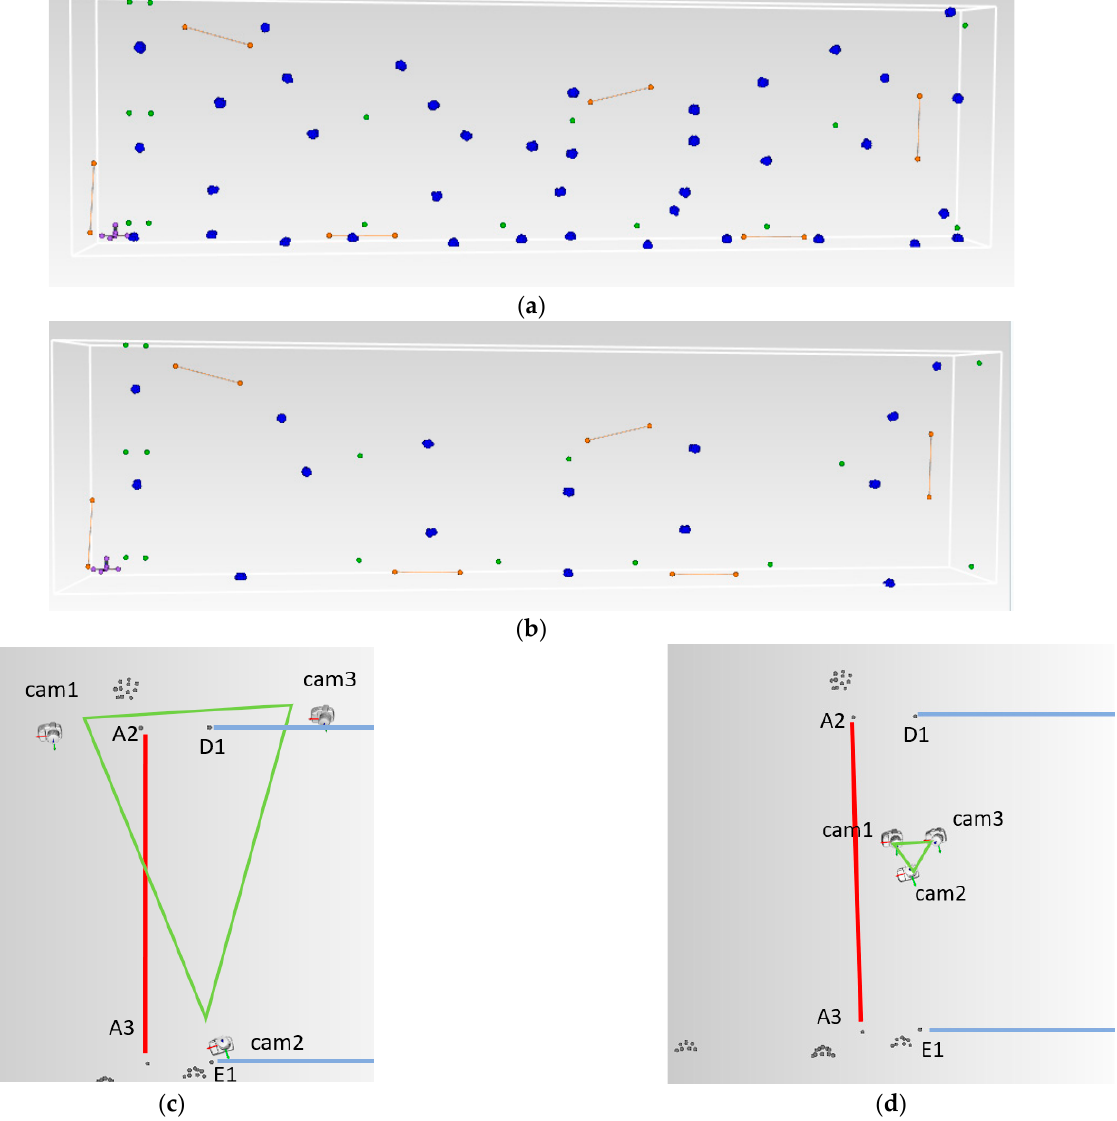
Figure 6. Simulation of the reference wall measurement scenarios: ( a ) layout of the auxiliary elements (large blue dots), scale bars (red lines), and targets of the reference wall (small green dots) for measurements with a high number of auxiliary elements; ( b ) layout for measurements with a low number of auxiliary elements (note the number of auxiliary elements has been reduced from 33 to 14); ( c ) detailed schematic from the front view for measuring the reference wall’s length (A2 to A3) using an efficient network.( d ) Detailed schematic from the front view for measuring a reference wall’s length (A2 to A3) using a deficient network.